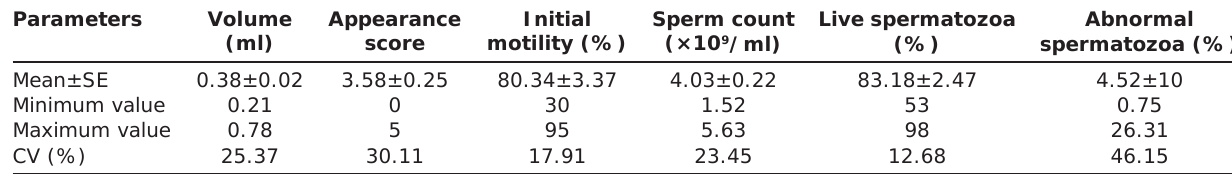
Table-1: The descriptive statistics on different quality characteristics of semen of RIR roosters.